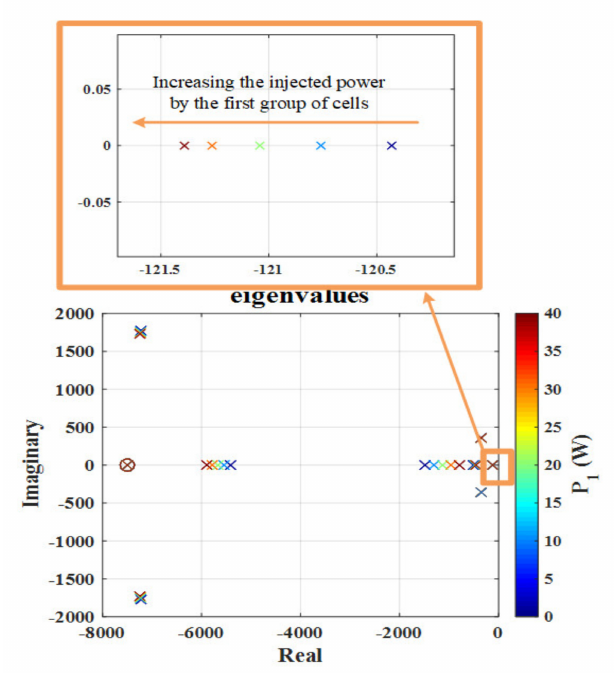
Figure 18. Dominant eigenvalues of the closed-loop system by changing the injected power of the first stack while the second stack injects 50 W and the other stacks inject the nominal power of 126